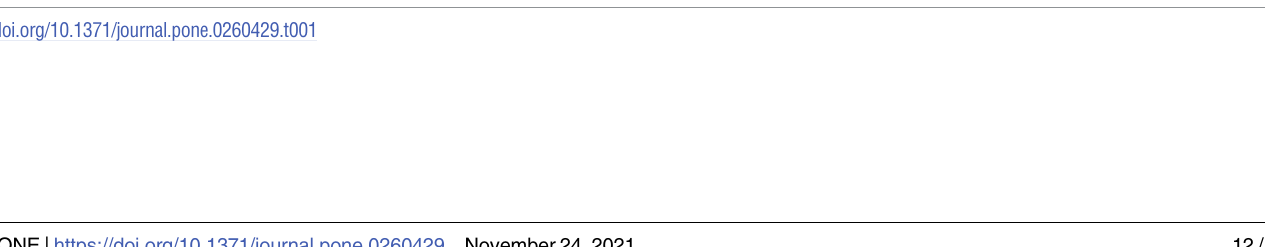
Table Notes: All models include random country-level intercepts and slopes for some variables. All quantitative variables are divided by twice their standard deviation for comparability. Results are based on five complete datasets with imputation for missing